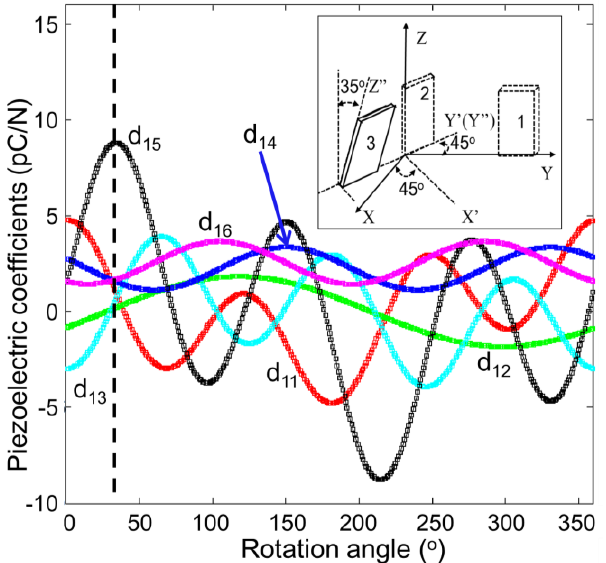
Figure 9. Thickness shear piezoelectric d for the ( XZlw )45°/θ crystal cut as a function of 15 rotation angle θ. The inset shows the schematic of the crystal cut ( XZlw )45°/35°.